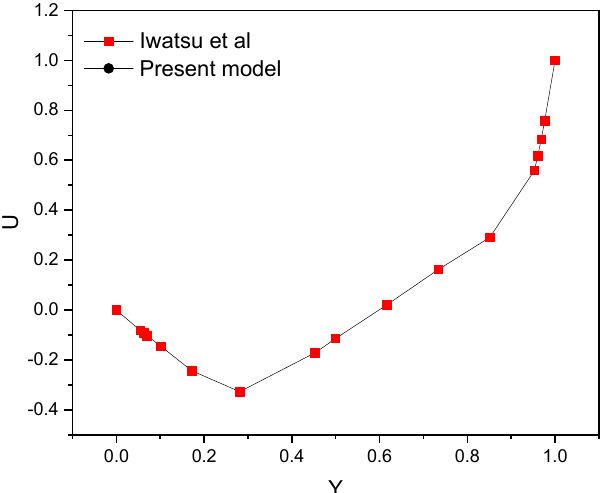
Figure 2. Comparison of velocity profile (current study vs. Iwatsu et al.’s data of